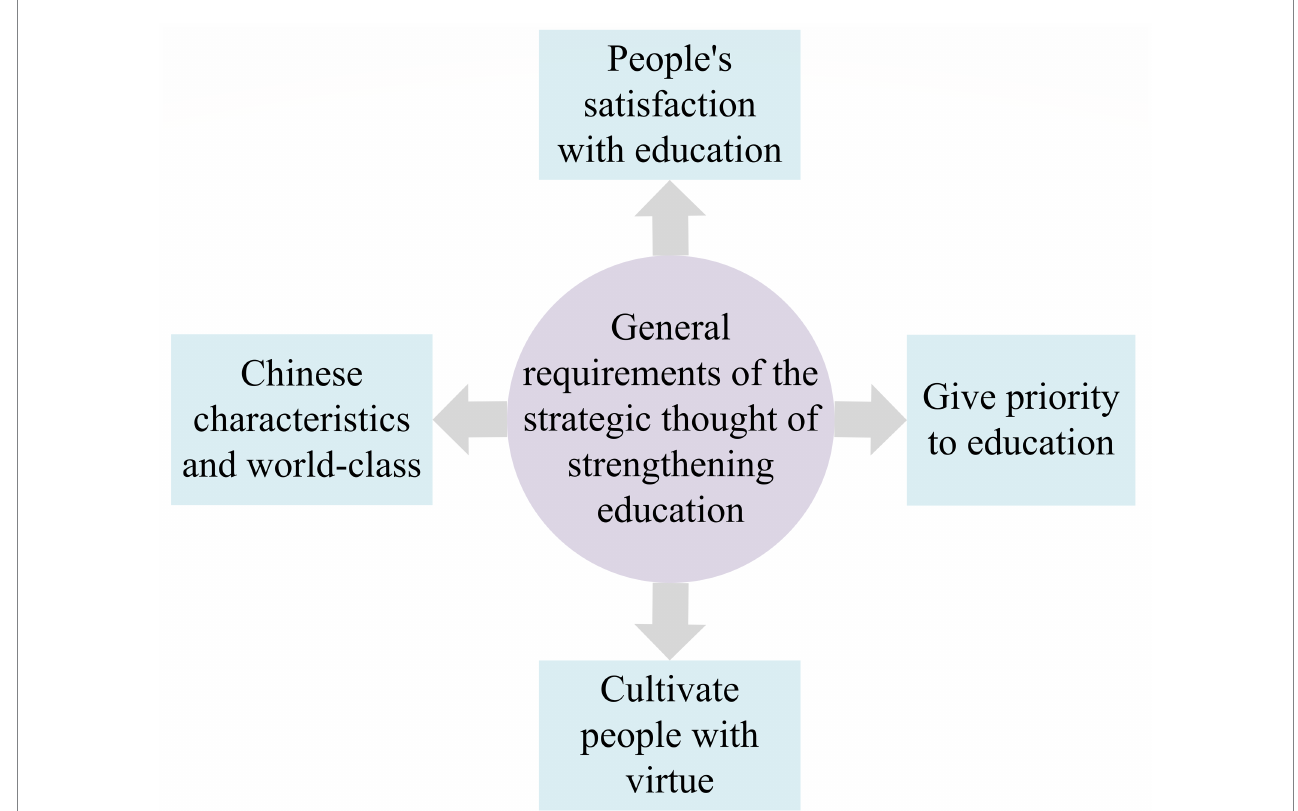
FIGURE 1 Reflection of the general requirements of the strategic thinking of strengthening the country through